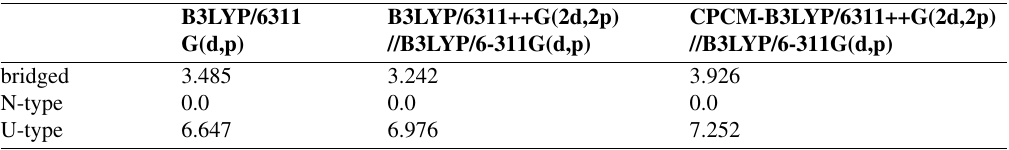
Table 1. The calculated relative energies of cations Cations Relative energy (kcal mol –1